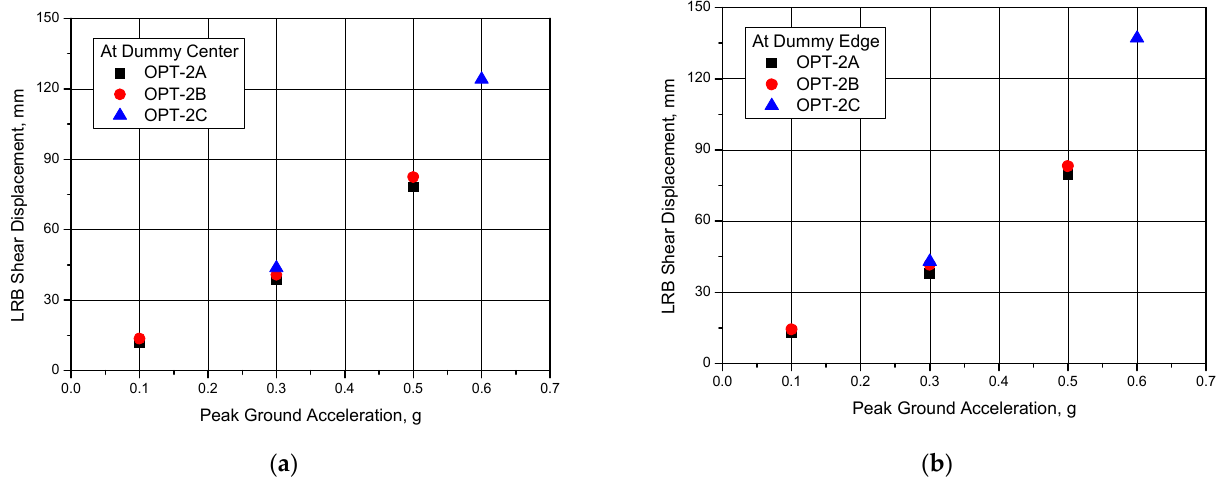
Figure 15. Measured maximum shear displacement of LRB: ( a ) At the center of dummy mass; ( b ) At the edge of dummy mass.